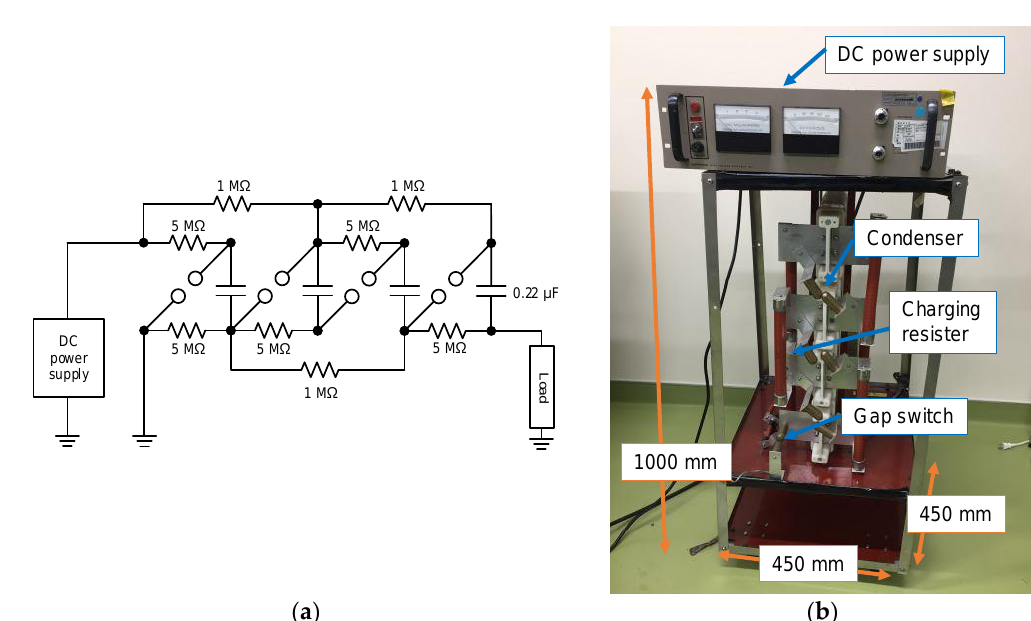
Figure 3. Circuit diagram ( a ) and photograph ( b ) of Marx generator.